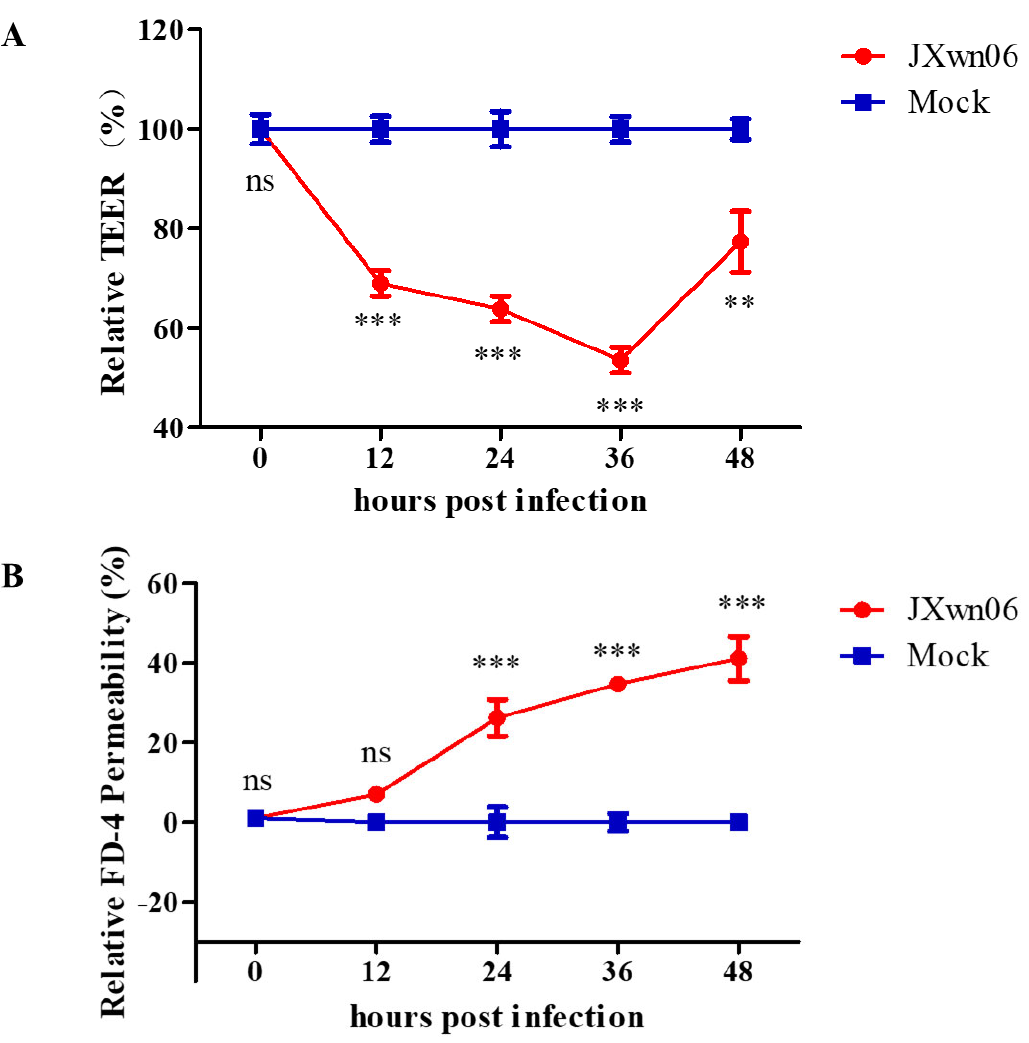
Figure 5. JXwn06 triggers endothelial barrier dysfunction in vitro. PMVECs were grown on transwell semi-permeable membranes (0.4 µ m pore size) and allowed to grow to confluence. Then, the primary PAMs plated in the basolateral chamber were inoculated with JXwn06 at an MOI of 5, and mock ‐ infected groups were set as a negative control. The permeability of the PMVEC monolayer was determined by TEER ( A ) and FITC–Dextran transwell assay ( B ). The data are shown as means ± SD (standard deviation), n = 3 independent experiments performed in triplicate. Asterisks indicate statistical significance (ns, p > 0.05; **, p < 0.01; ***, p < 0.001).